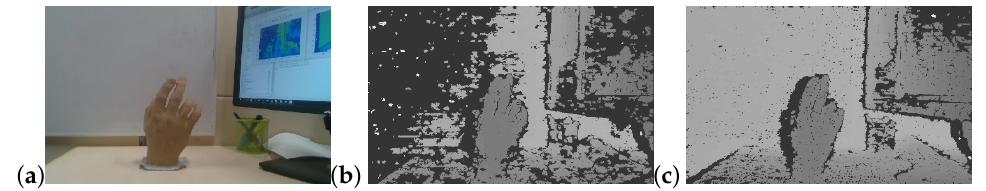
Figure 3. Noise is dependent on camera laser power. ( a ) RGB. ( b ) Low laser power. ( c ) High laser power.